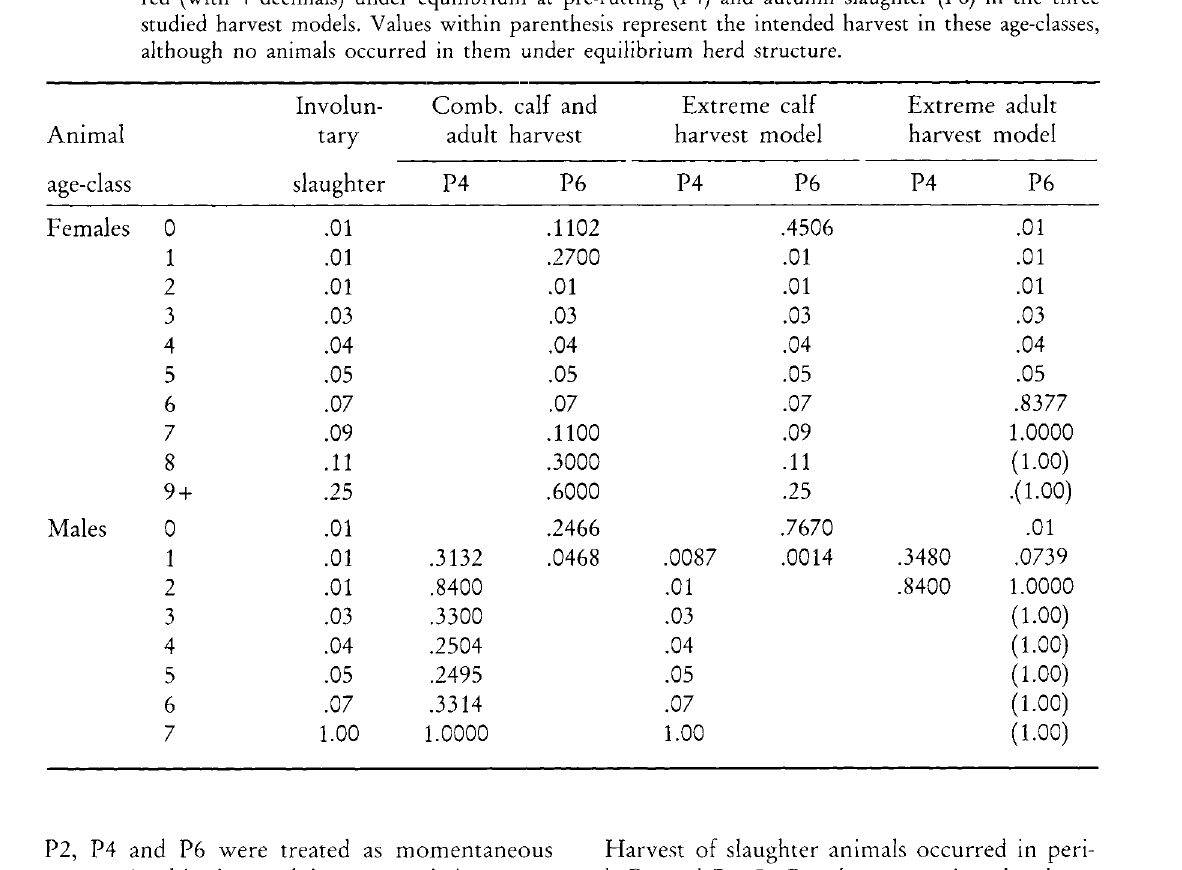
Table 2. Predetermined involuntary slaughter (figures with 2 decimals) and the ultimate proportions slaughte red (with 4 decimals) under equilibrium at pre-rutting (P4) and autumn slaughter (P6) in the three studied harvest models. Values within parenthesis represent the intended harvest in these age-classes, although no animals occurred in them under equilibrium herd